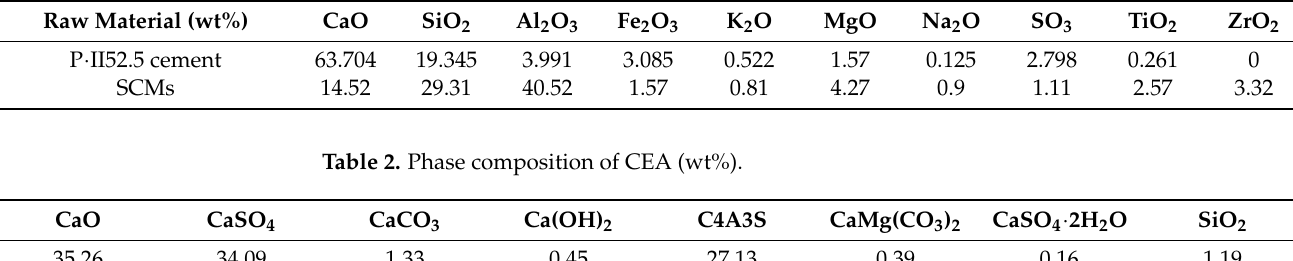
Table 1. Chemical composition of the raw materials.